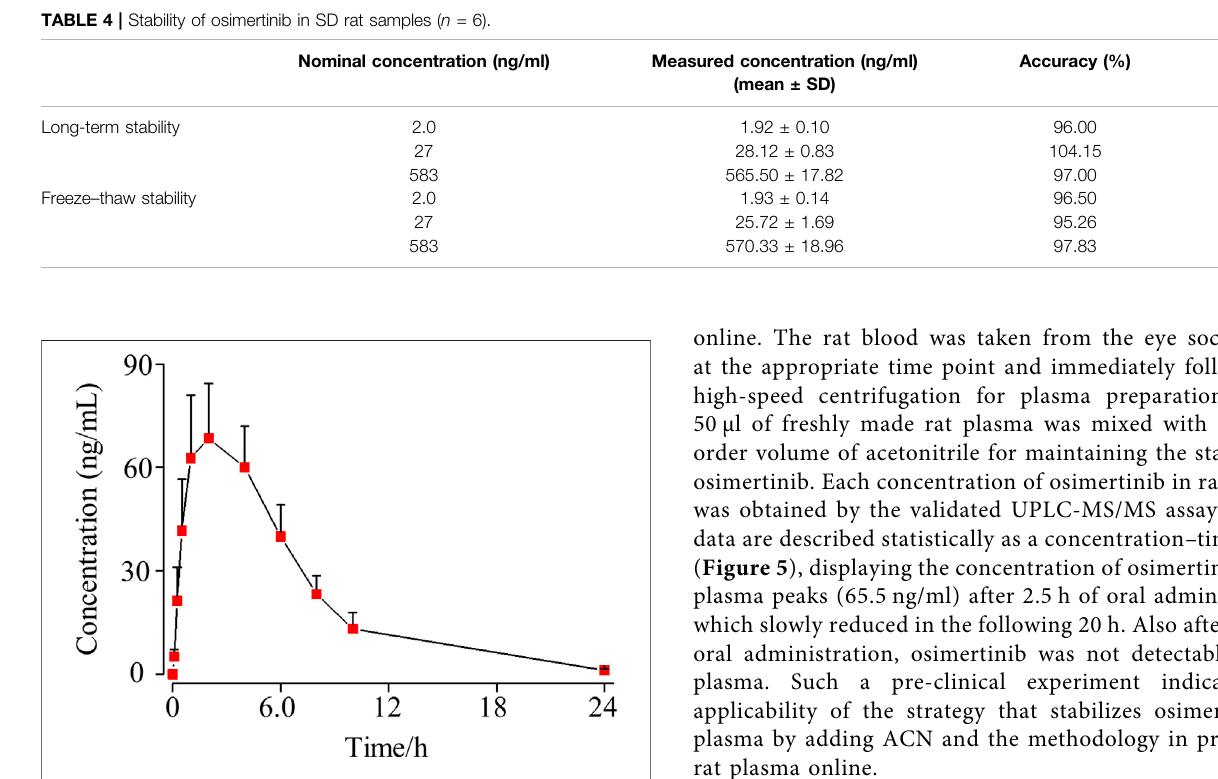
FIGURE 5 | SD rat plasma concentration – time curve of osimertinib (mean ± standard deviation, n = 5) after oral administration.